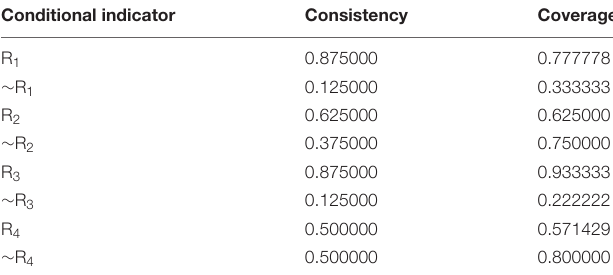
TABLE 7 | Necessity